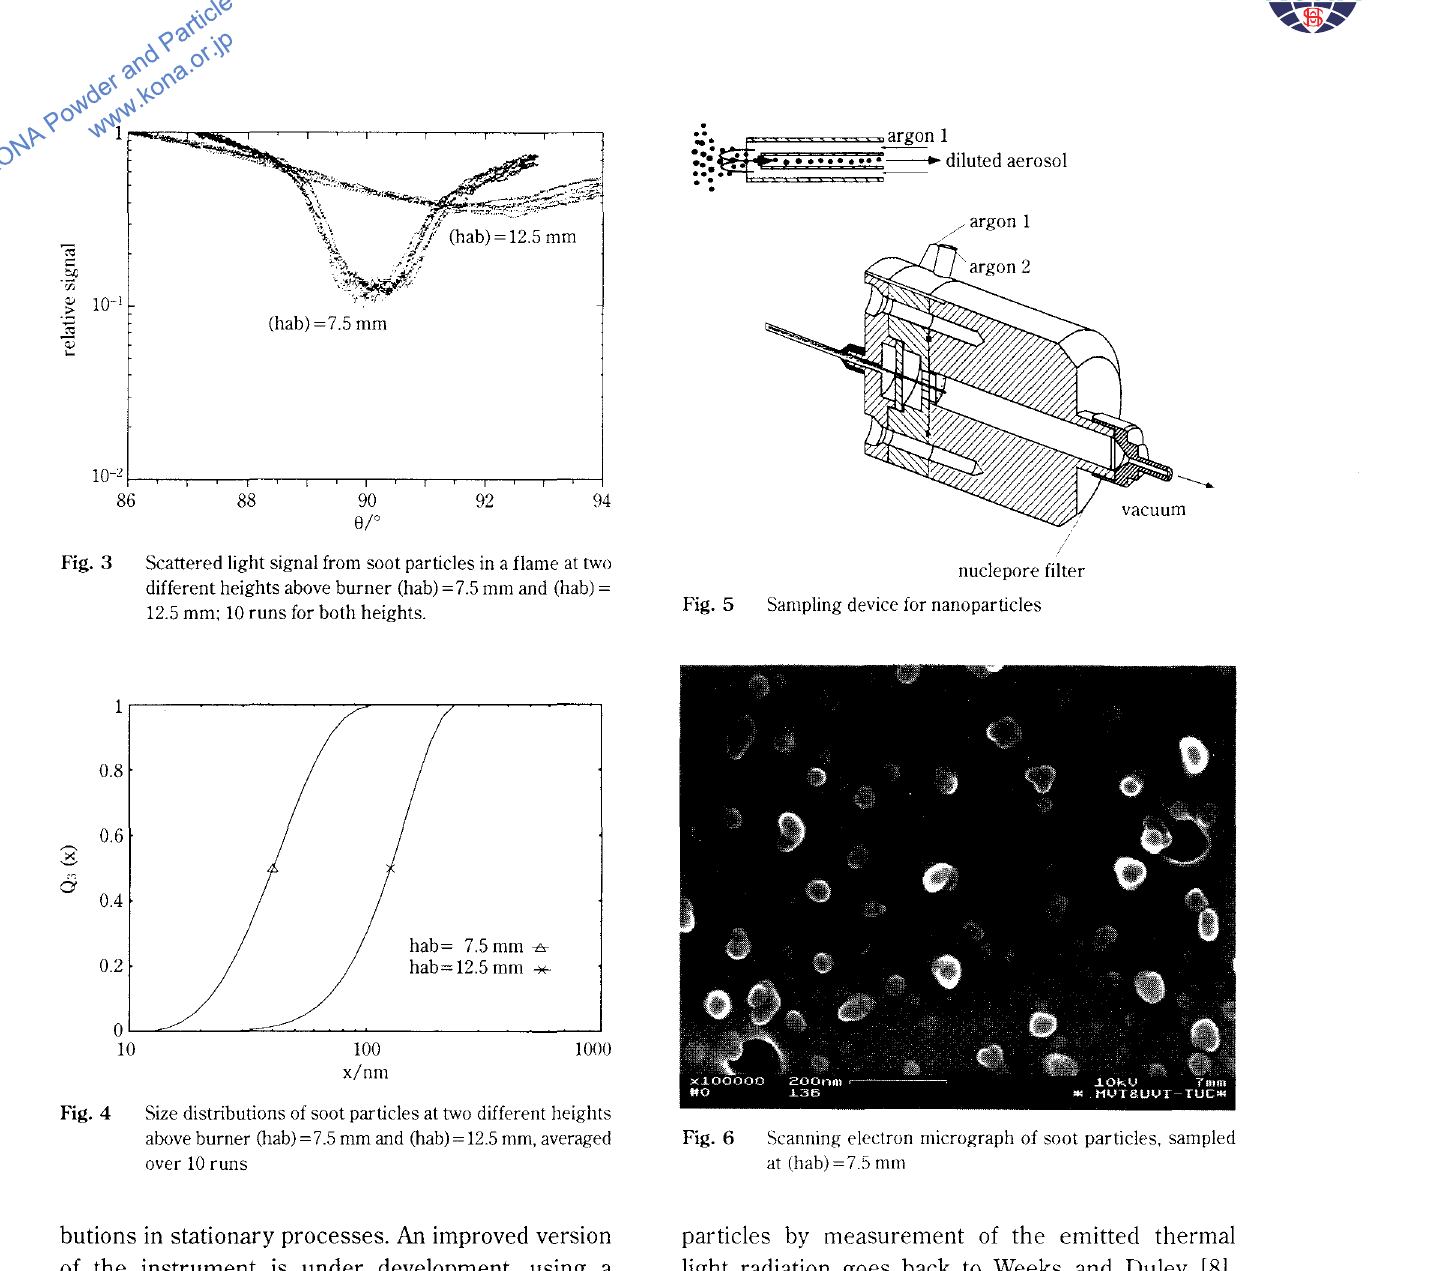
Fig. 6 Scanning electron micrograph of soot particles. sampled at